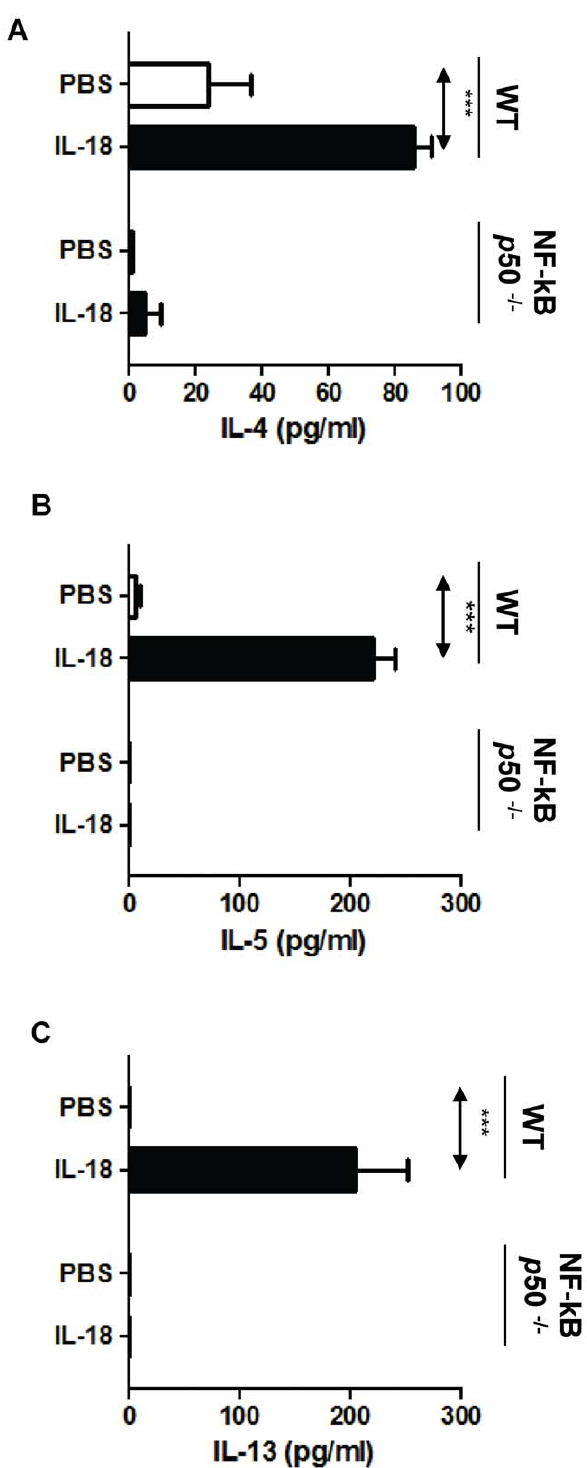
Figure 4. Effect of disruption of NF- k B p50 on Th2 differenti- ation of naı¨ve CD4 T-cells treated with IL-18. CD4 + T-cells from Wild-type (WT) and NF- k B p50 2 / 2 mice were cultured with IL-18 in the differentiation phase, restimulated with con A, and secretion of IL-4 ( A ), IL-5 ( B ) and IL-13 ( C ) was quantified by ELISA. n=5 2 7 per group.